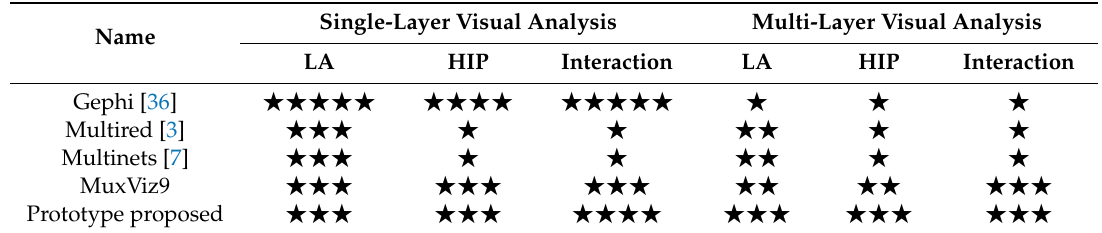
Table 2. Comparison of analytical capabilities of di ff erent multiplex networks visualization